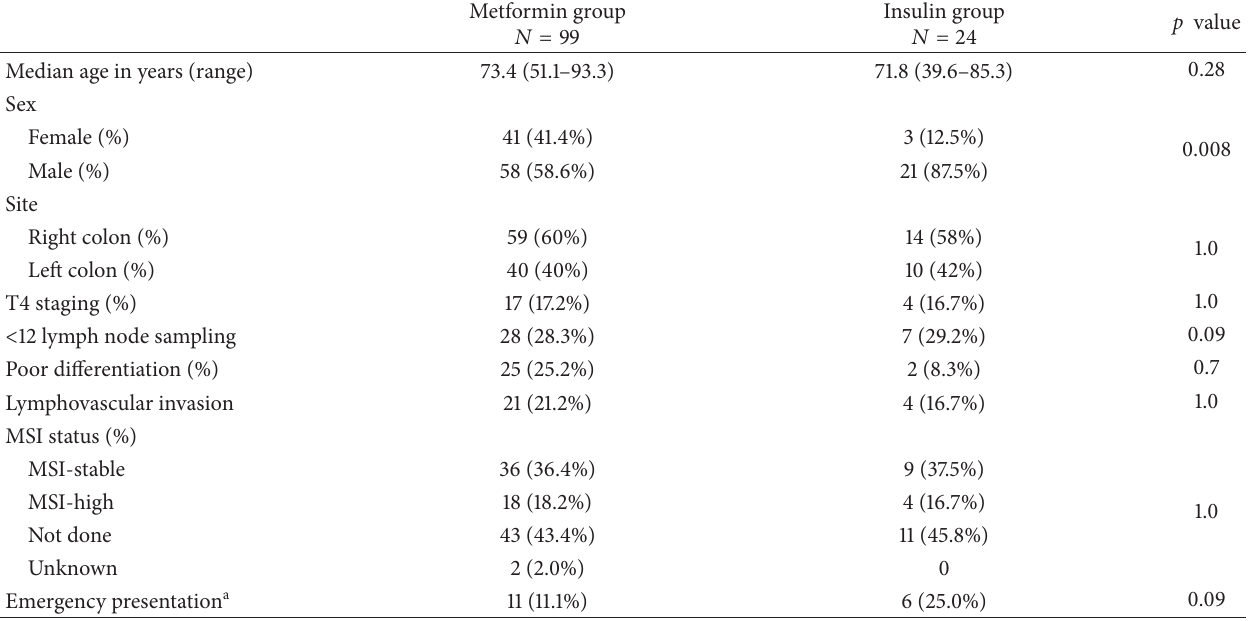
Table 2: Pathologic features of diabetes patients: metformin and insulin treated